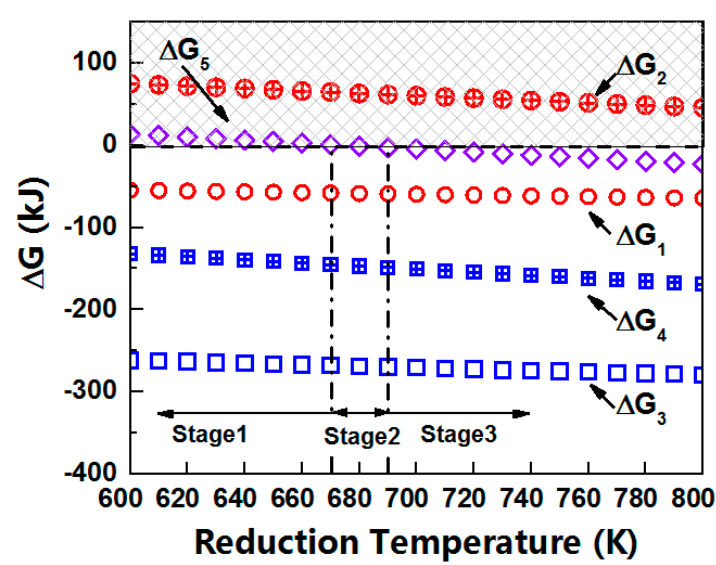
Figure 9. Gibbs free energy changes ( ∆ G) of the oxidation-reduction reactions in the thermal hydrogen of lead silicate glass on the surface of MCPs from 620 K to 770 K. Only the negative ∆ G can react spontaneously at constant pressure (P = 1.1 × 10 5 Pa) and a stationary temperature.